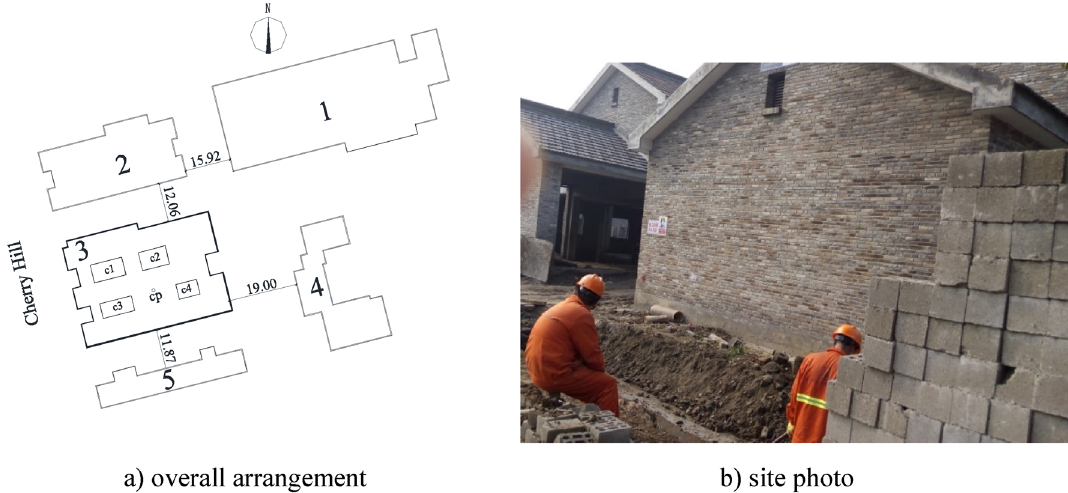
Figure 1. Overall arrangement and site photo of the Ganshuixiang project (unit: m). 1–5 denote No. 1–5 section of Ganshuixiang; c1-4 denote No. 1–4 courtyard; cp is soil sampling point;